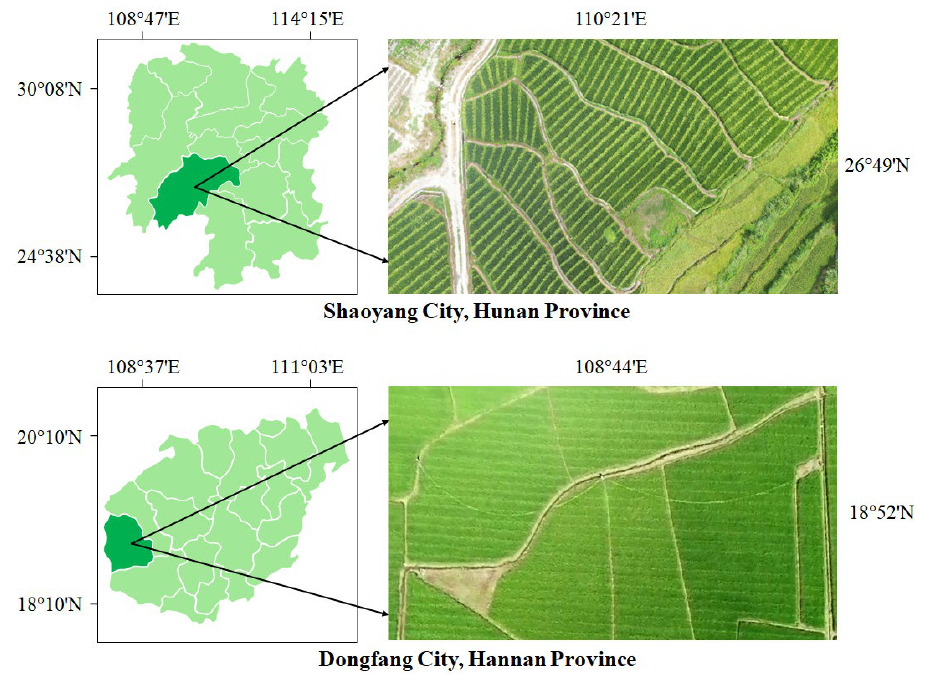
Figure 1. Overview of the experiment site.